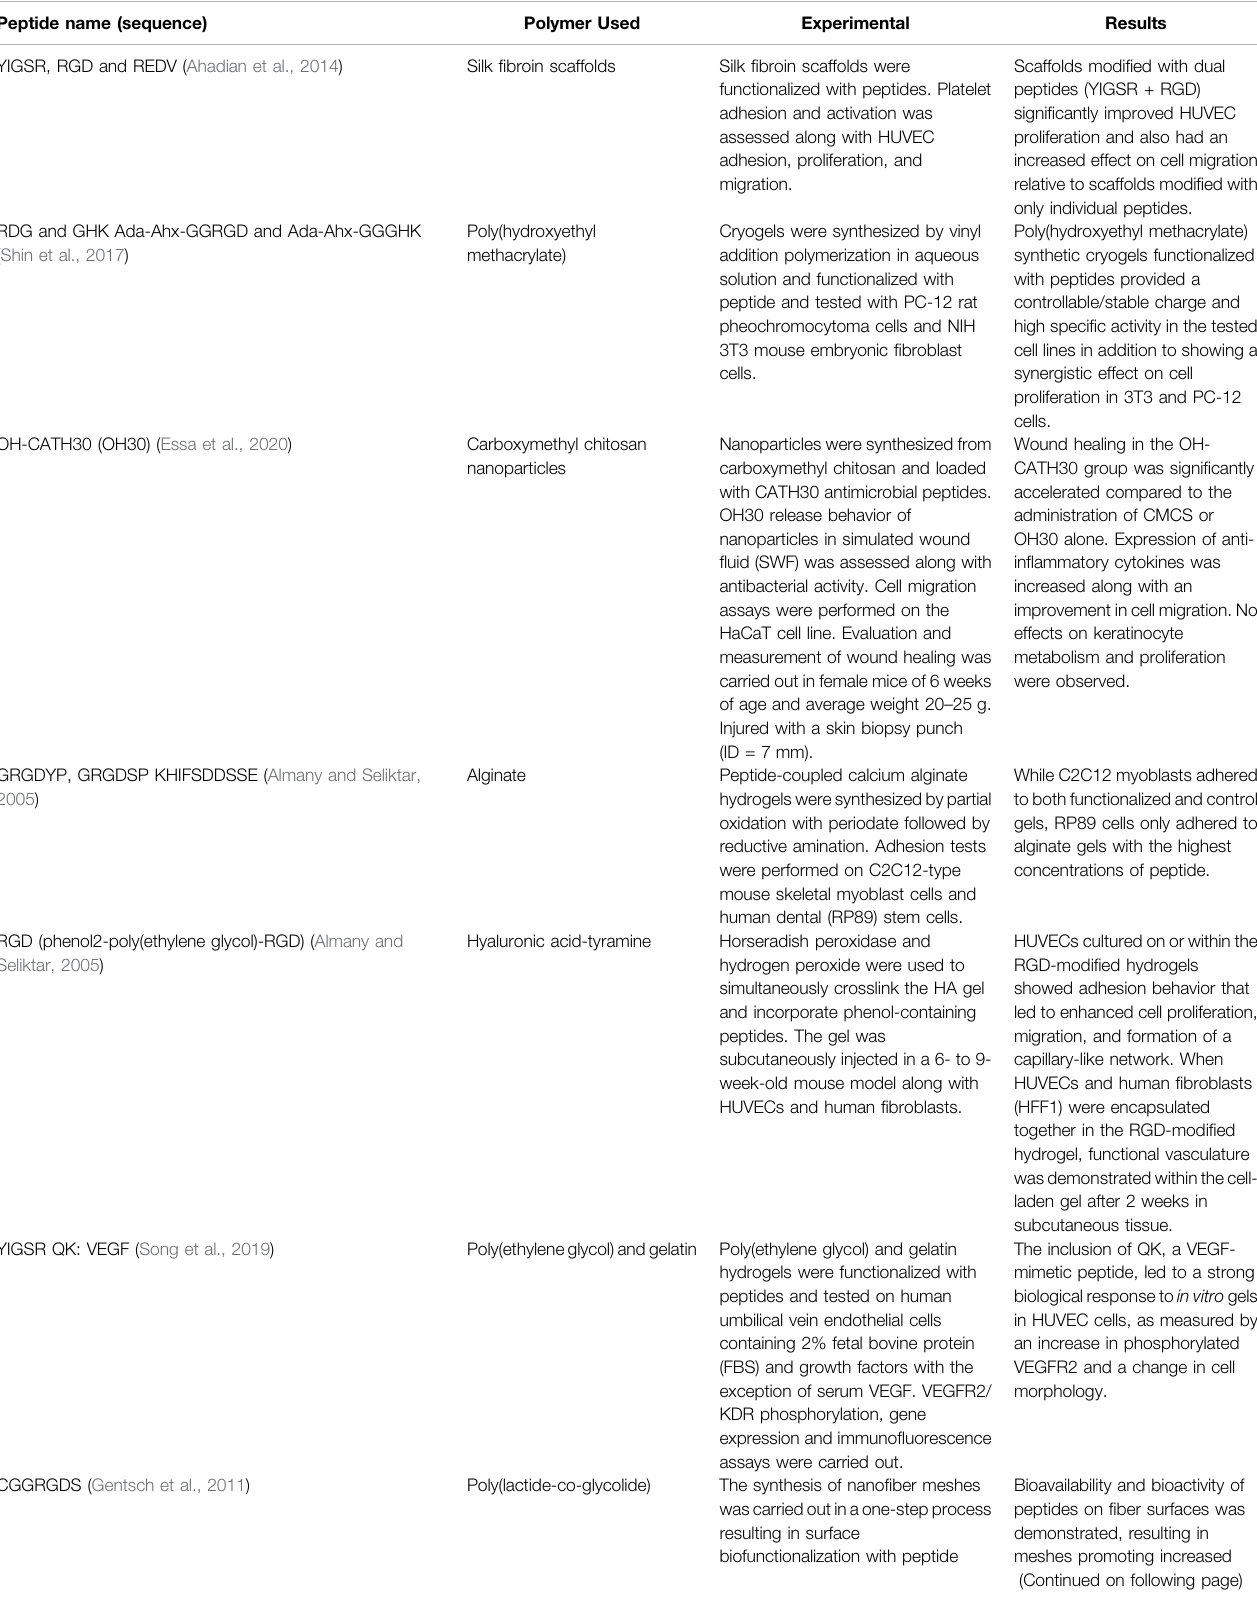
TABLE 1 | ( Continued ) Summary of peptide